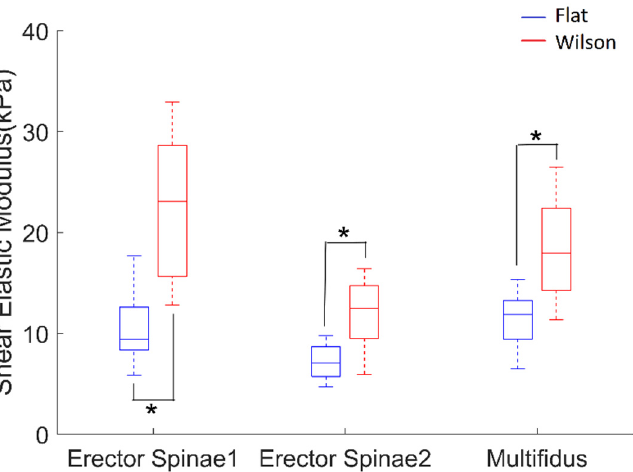
Figure 7. Shear elastic modulus of erector spinae 1, erector spinae 2, and multifidus muscles while in flat (blue) and Wilson (red) table postures. Each box plot indicates 25th (Q1), 50th (Q2), and 75th (Q3) percentiles of the data. Whisker indicates Q3 + 1.5 × (Q3 − Q1) and Q1 − 1.5 × (Q3 − Q1). *, p < 0.05.